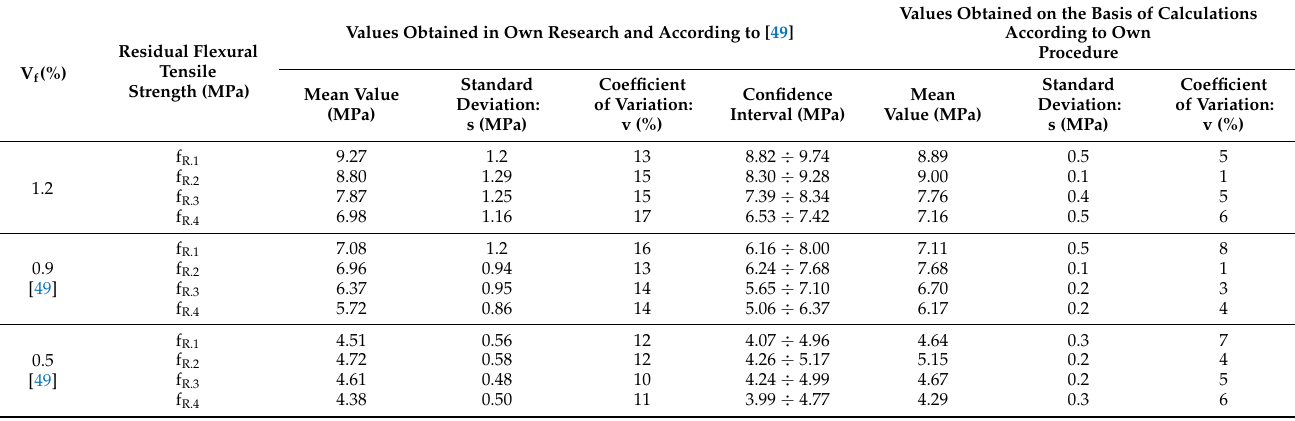
Table 6. Experimental and calculated values of residual flexural tensile strengths of the fiber